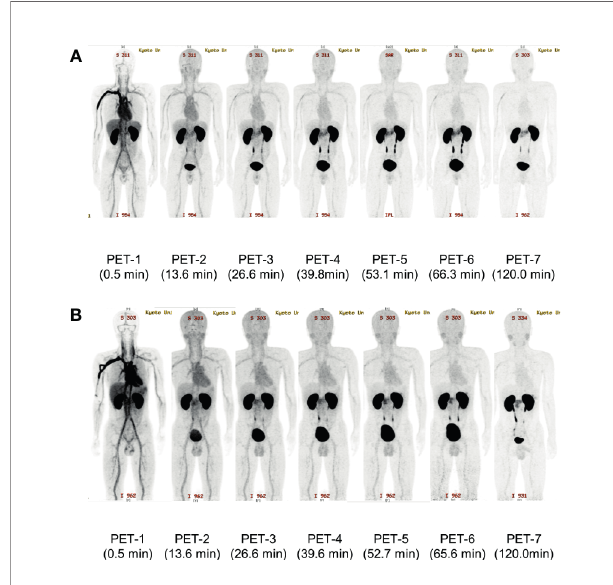
FIGURE 2 | The representative maximum intensity projection images of [ 18 F]FB(ePEG12)12-exendin-4 ( 18 F-Ex4) PET/CT. The maximum intensity projection images of each PET scan in Case 2 (A) and Case 3 (B) are shown. The fi rst PET scan was performed immediately after 18 F-Ex4 administration and following fi ve-time scans consisting of 2 min/frame × 5 frames (PET 1 – 6) were undertaken. The fi nal scan was started at 2 h after administration of 18 F-Ex4 (PET 7). The numbers in parentheses indicate the time after 18 F-Ex4 administration. FIGURE 4 | The representative time course of the mean standardized uptake